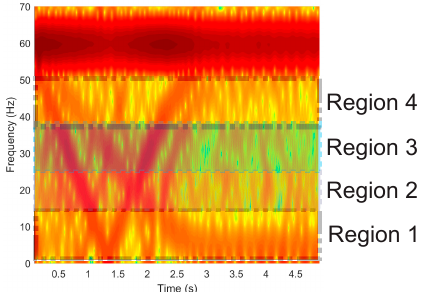
Figure 8. Frequency bands considered in the STFT maps.